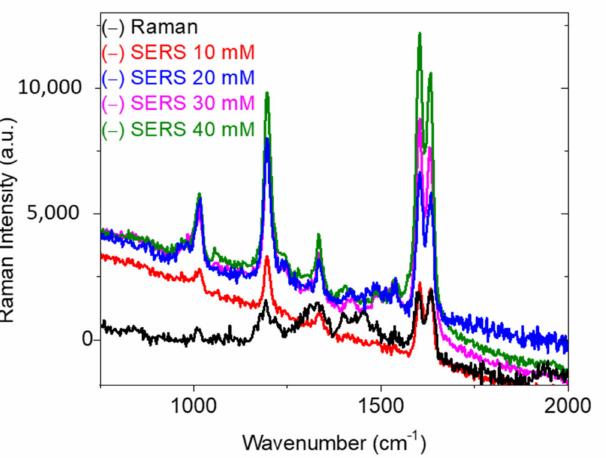
Figure 11. The Raman and SERS spectra of BPE at 10 − 10 M for AgNPs prepared with different silver precursor concentrations. Raman measurements were obtained with 10 − 2 M of BPE. Spectra were obtained at P = 5 mW over 5 s. Each curve is an average of 10 spectra collected from different positions on the